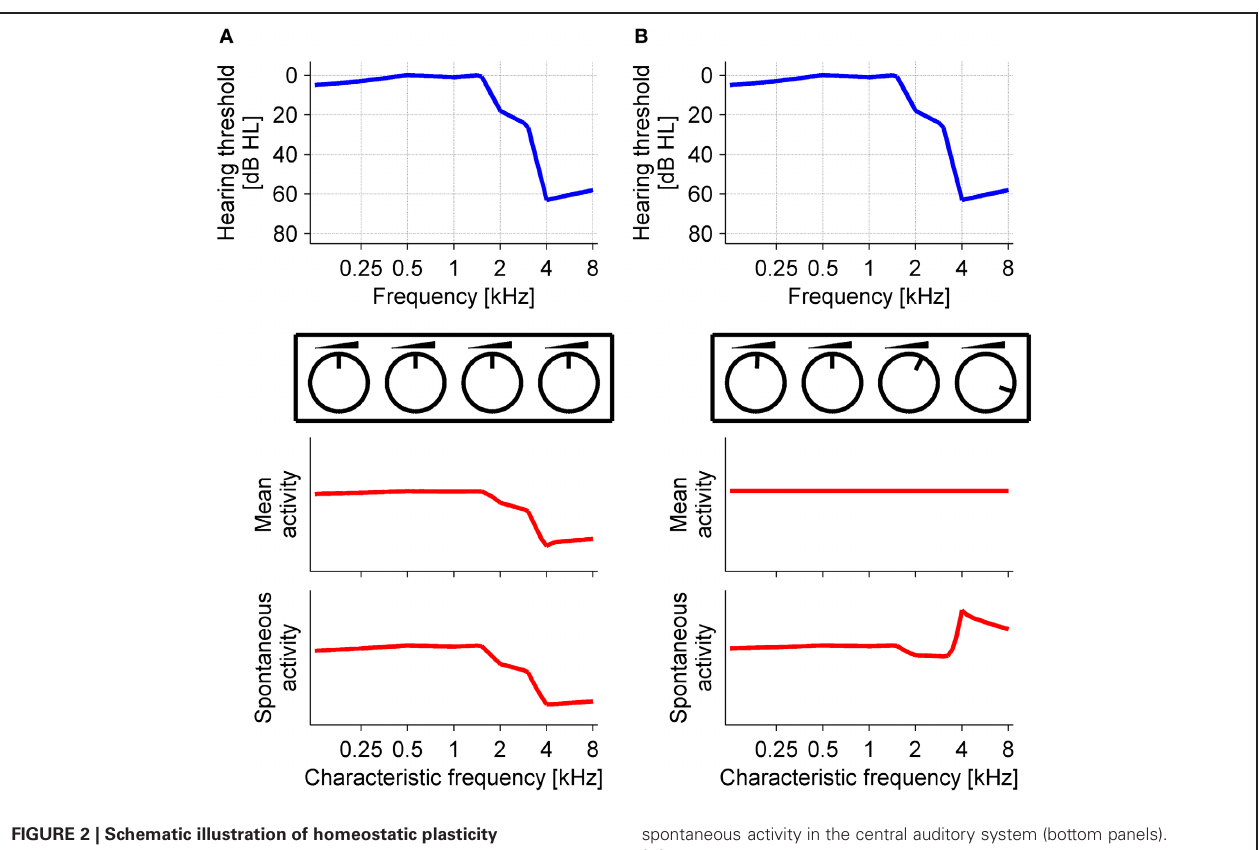
spontaneous activity in the central auditory system (bottom panels). (B) After homeostatic plasticity: the response gain has been increased to restore the mean activity of central auditory neurons back to its target level. However, spontaneous activity is amplified through the increased gain, giving rise to increased spontaneous firing rates in the region of hearing